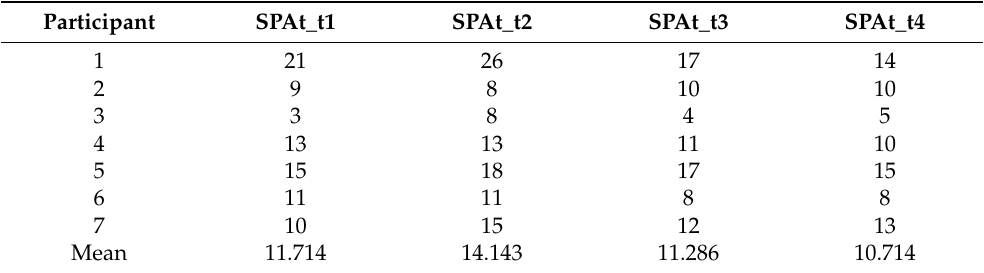
Table 17. Speech–pause ratio (seconds per minute) individual and mean measurements at four assessment time points.